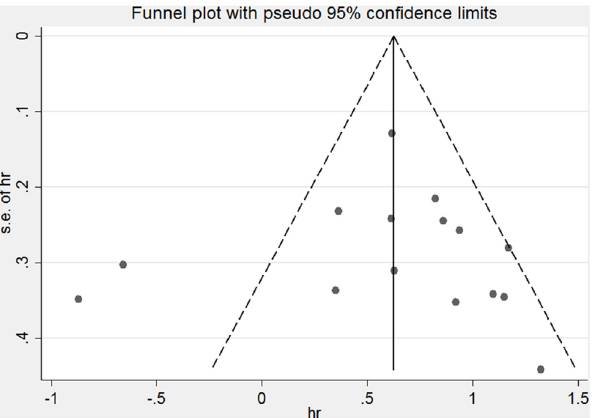
Fig 4. Funnel plot for the assessment of potential publication bias regarding OS in the